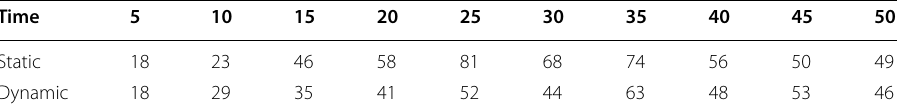
Table 3 The numbers of node in SKDTree